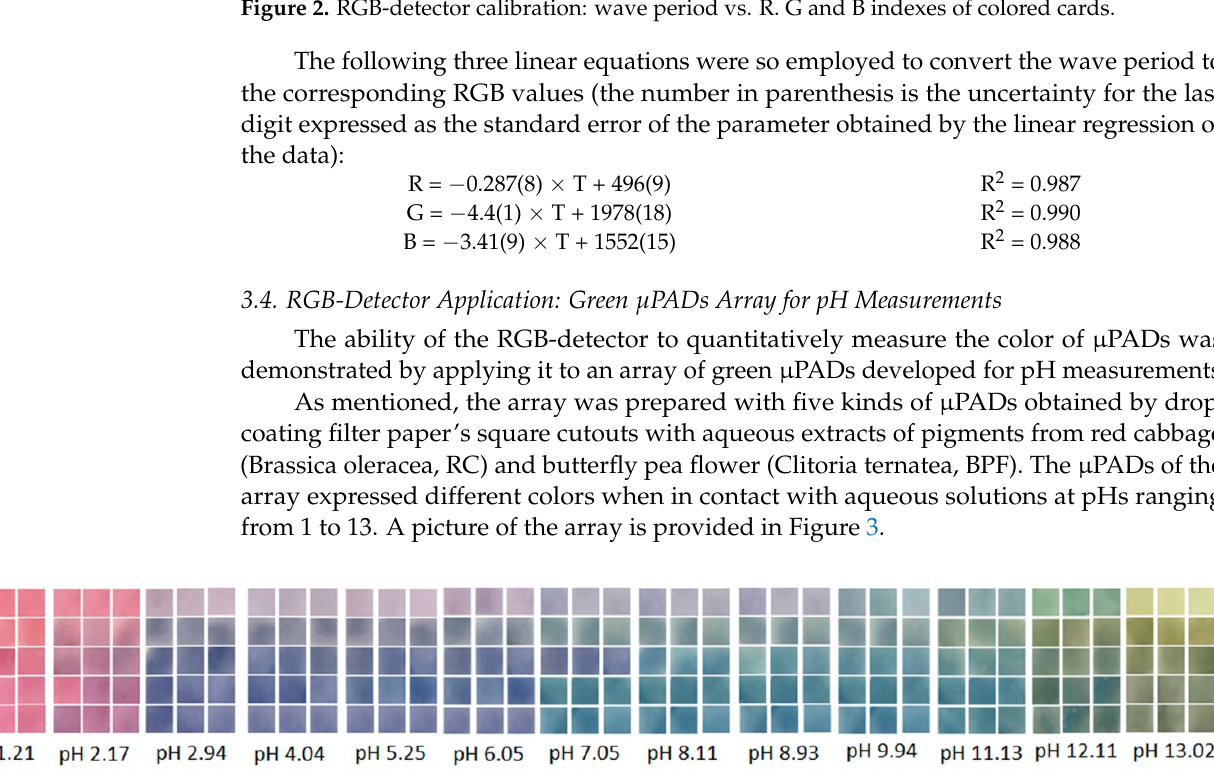
Figure 2. RGB-detector calibration: wave period vs. R. G and B indexes of colored cards.